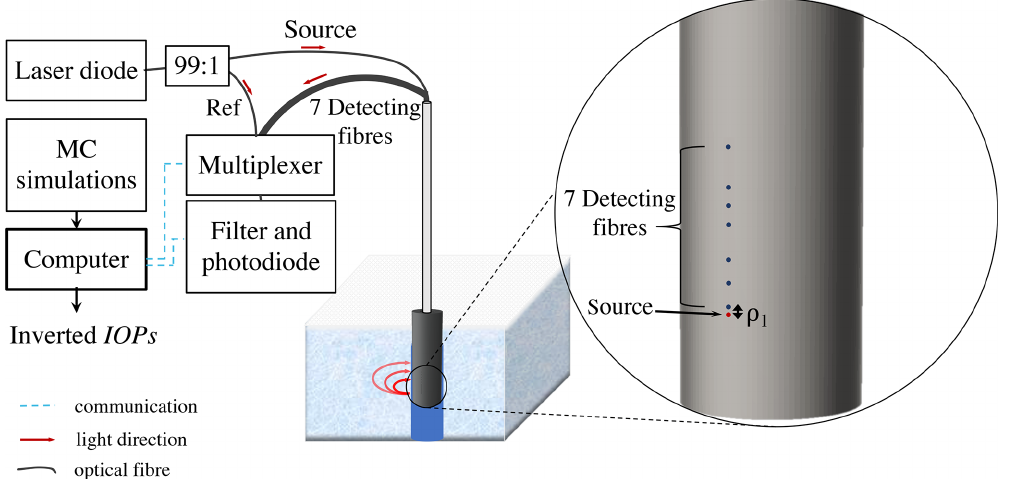
Figure 1. Experimental setup schematic. The 2in. probe was designed to fit an auger hole drilled through the ice and to measure sideward on the edge of the hole. A laser diode emitted at λ = 633 ± 2nm with a full width at half maximum of 1.4nm and optical power of 300mW. A 99 : 1 fibre optic coupler divided optical power between a leg used to guide light up to the probe head where injection into sea ice occurred and the reference leg. Detecting optical fibres at distances ρ 1 − 7 collected backscattered laser light (curved red arrows). An optical multiplexer selected the fibre to be read by a photodiode. A reflective bandpass filter centred at λ = 633nm with a full width at half maximum of 5nm was placed before the photodiode to reject sunlight. A single-board computer with an easy-to-operate touch screen controlled the multiplexer, obtained (cid:56) readings from the photodiode and did a field inversion on b .